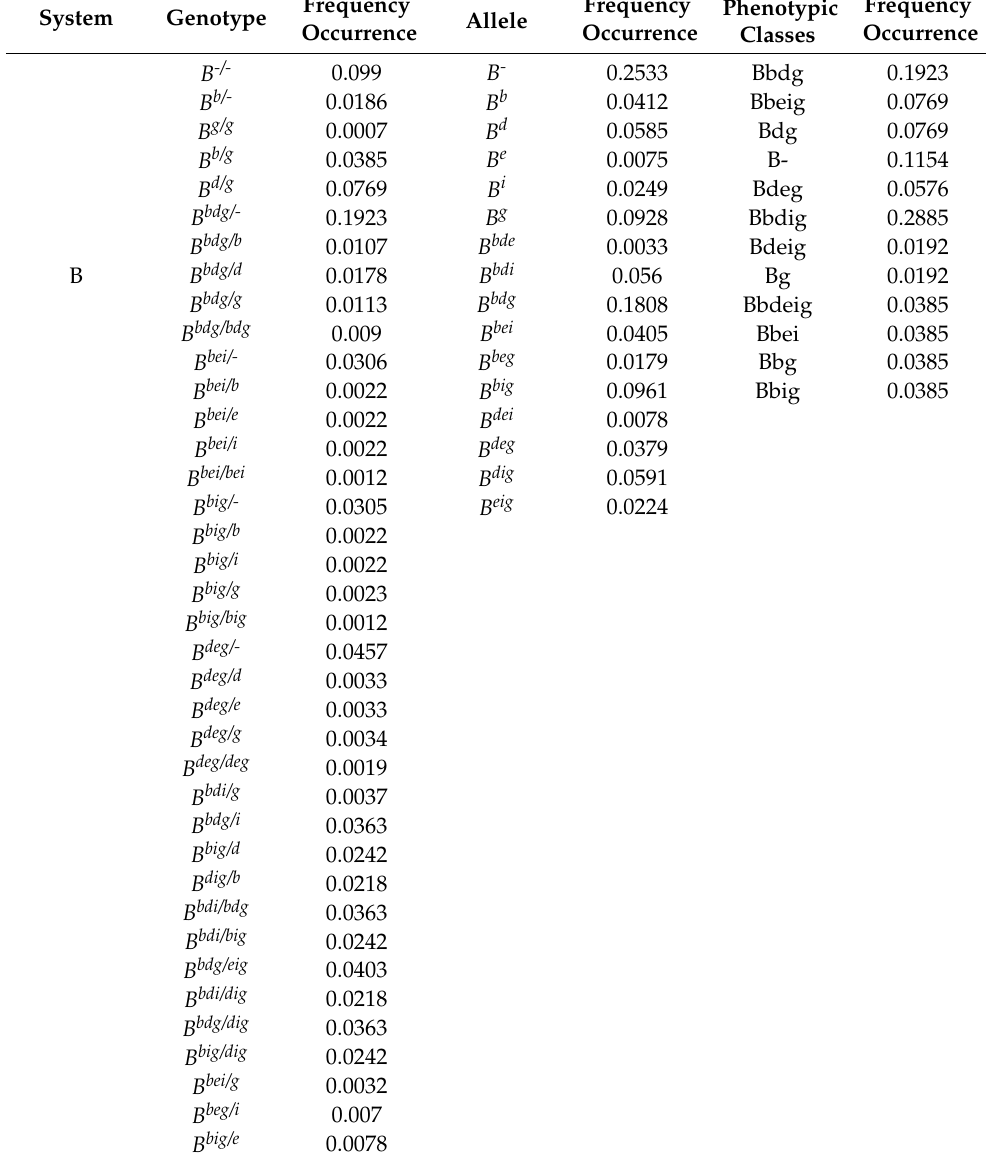
Table 2. Frequency of genetic factors in the B blood group system in the Romanov breed (n =